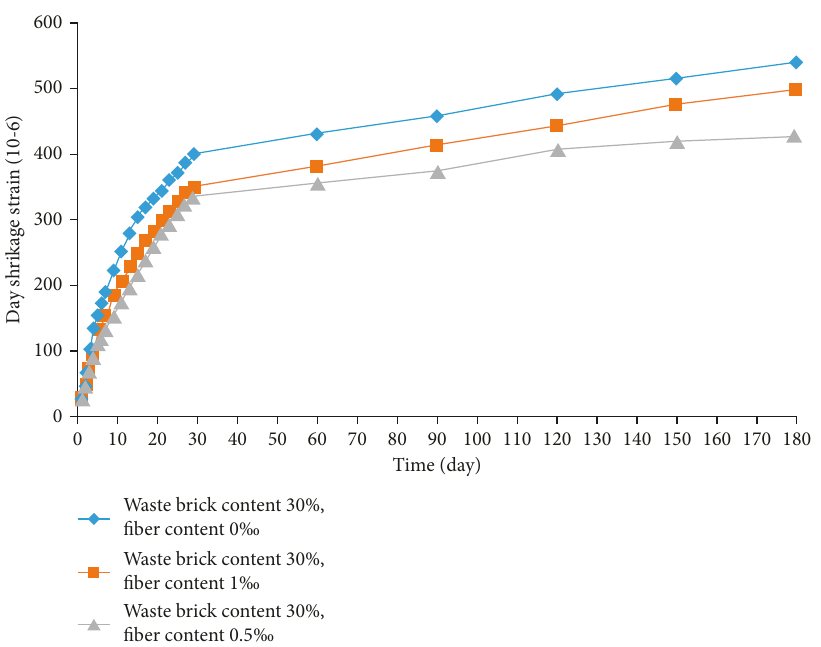
Figure 21: Relation between dry shrinkage strain and